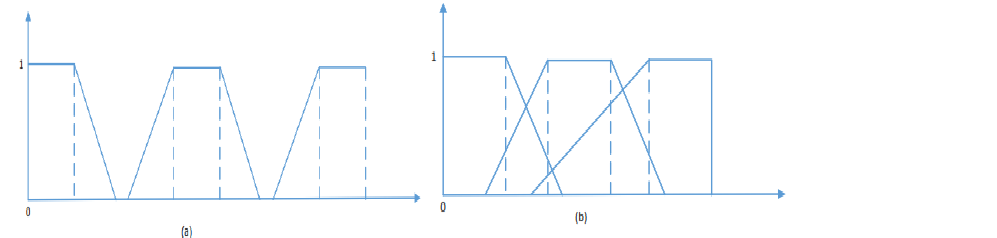
Figure 2. Two types of unsuitable membership